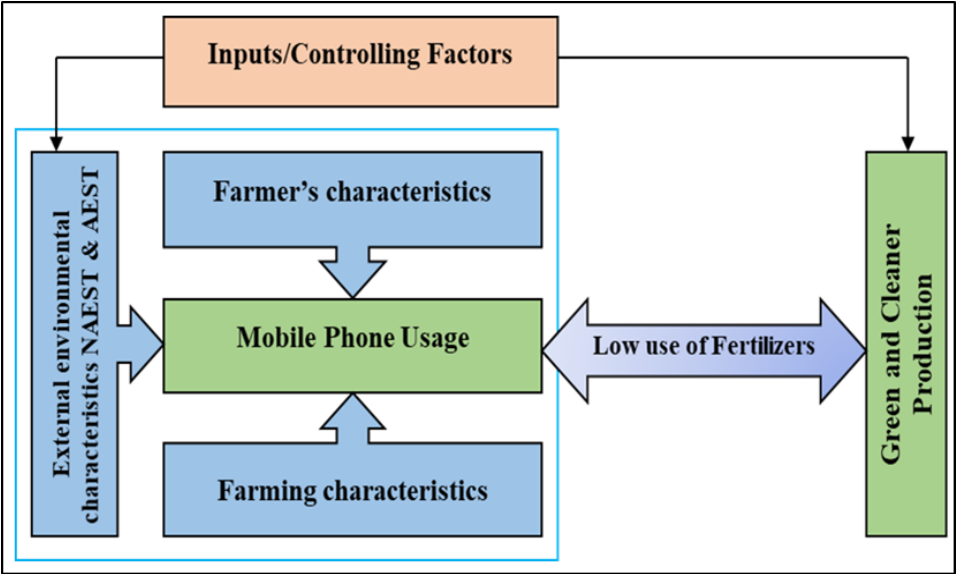
Figure 1. Conceptual framework of the study.